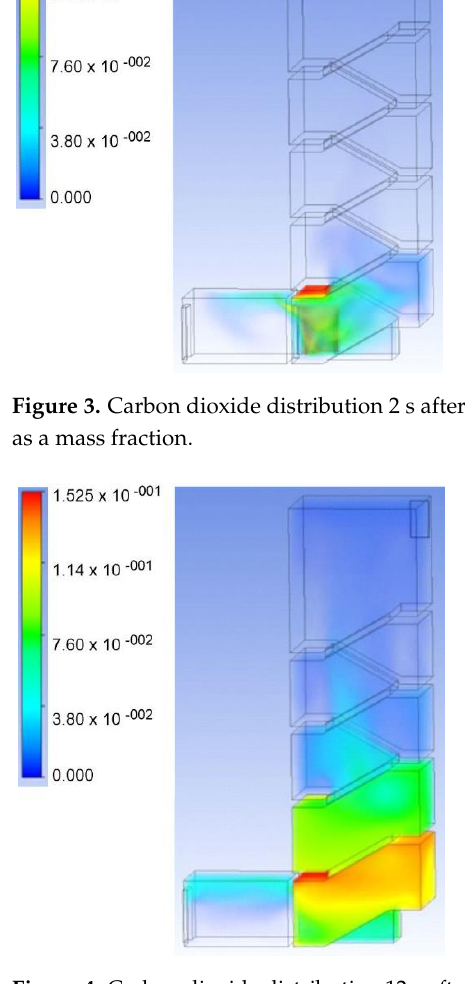
Figure 3. Carbon dioxide distribution 2 s after the door was opened. Carbon dioxide was meas- ured as a mass fraction.